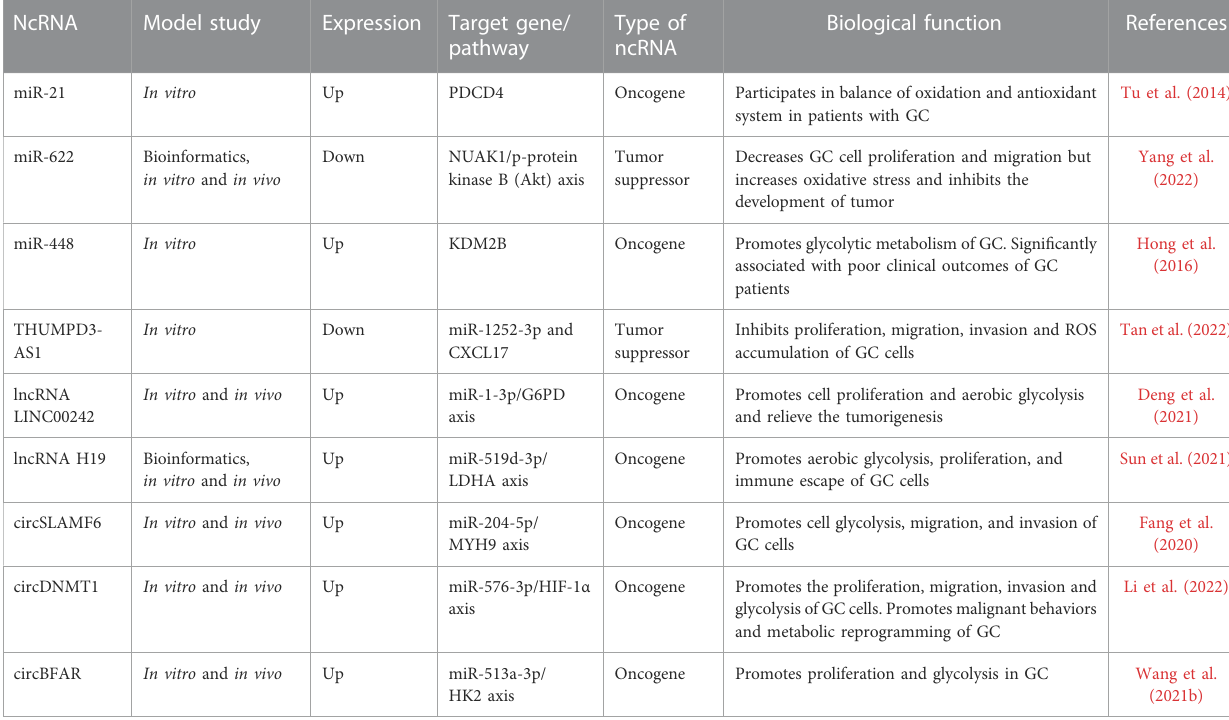
TABLE 4 Some non-coding RNAs (ncRNAs) that regulate oxygen adaptive metabolism in gastric cancer (GC) cells.